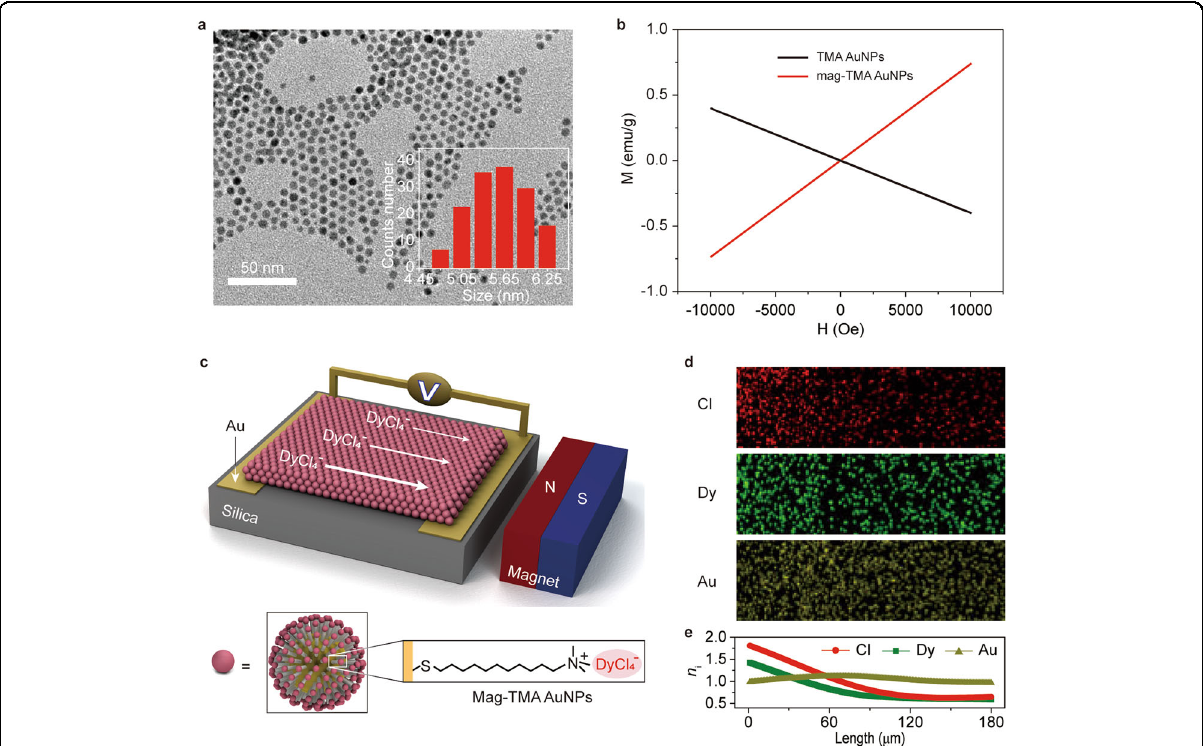
Fig. 1 Scheme of the device and demonstration of magnetic ionic gradients. a TEM image of AuNPs and particle size statistics. b M-H curves of TMA and mag-TMA AuNPs. c The top scheme illustrates the metal nanoparticle nanogenerator in which the magnetic counterions (DyCl 4- ) migrate toward the electrode close to the magnet. The bottom scheme shows an individual mag-TMA gold nanoparticle and one of its magnetic ligands with an associated DyCl 4- counterion. d EDS mapping of Cl, Dy, and Au elements within the mag-TMA AuNP fi lm after placing a magnet (200 mT) on the left side of the fi lm for approximately 10 min. e Corresponding pro fi les of Cl, Dy, and Au elemental